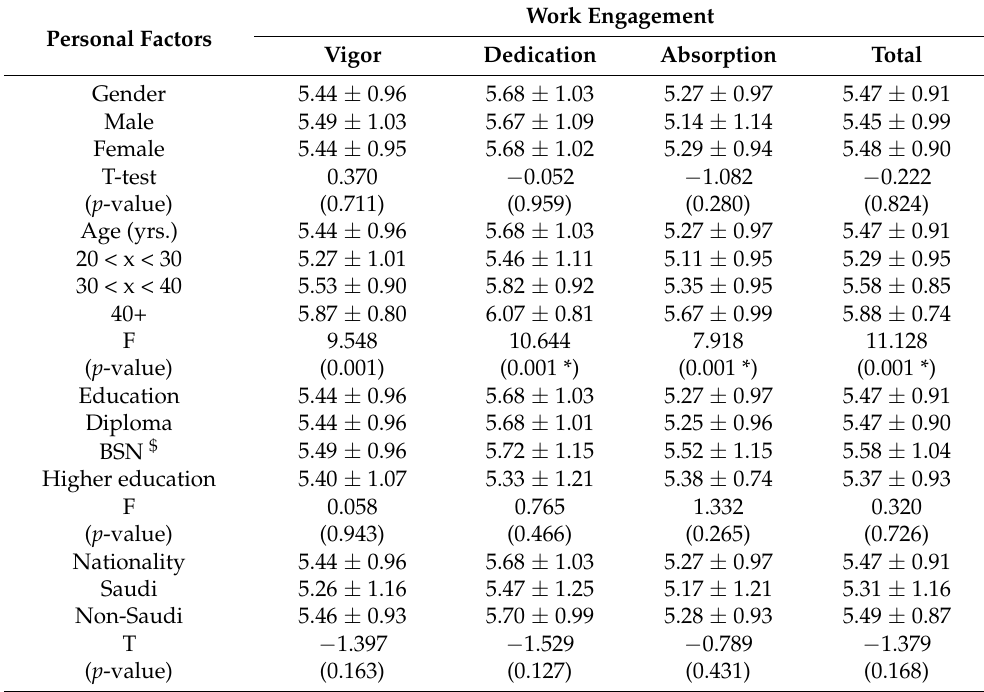
Table 3. Association between Level of Work Engagement and Personal